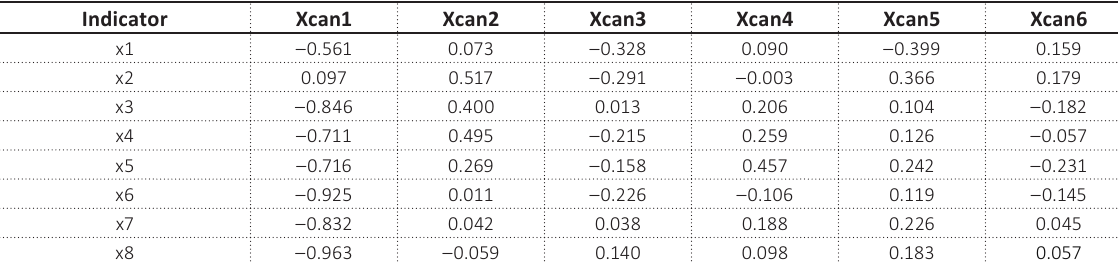
Table 6. Loading of higher education and training indicators